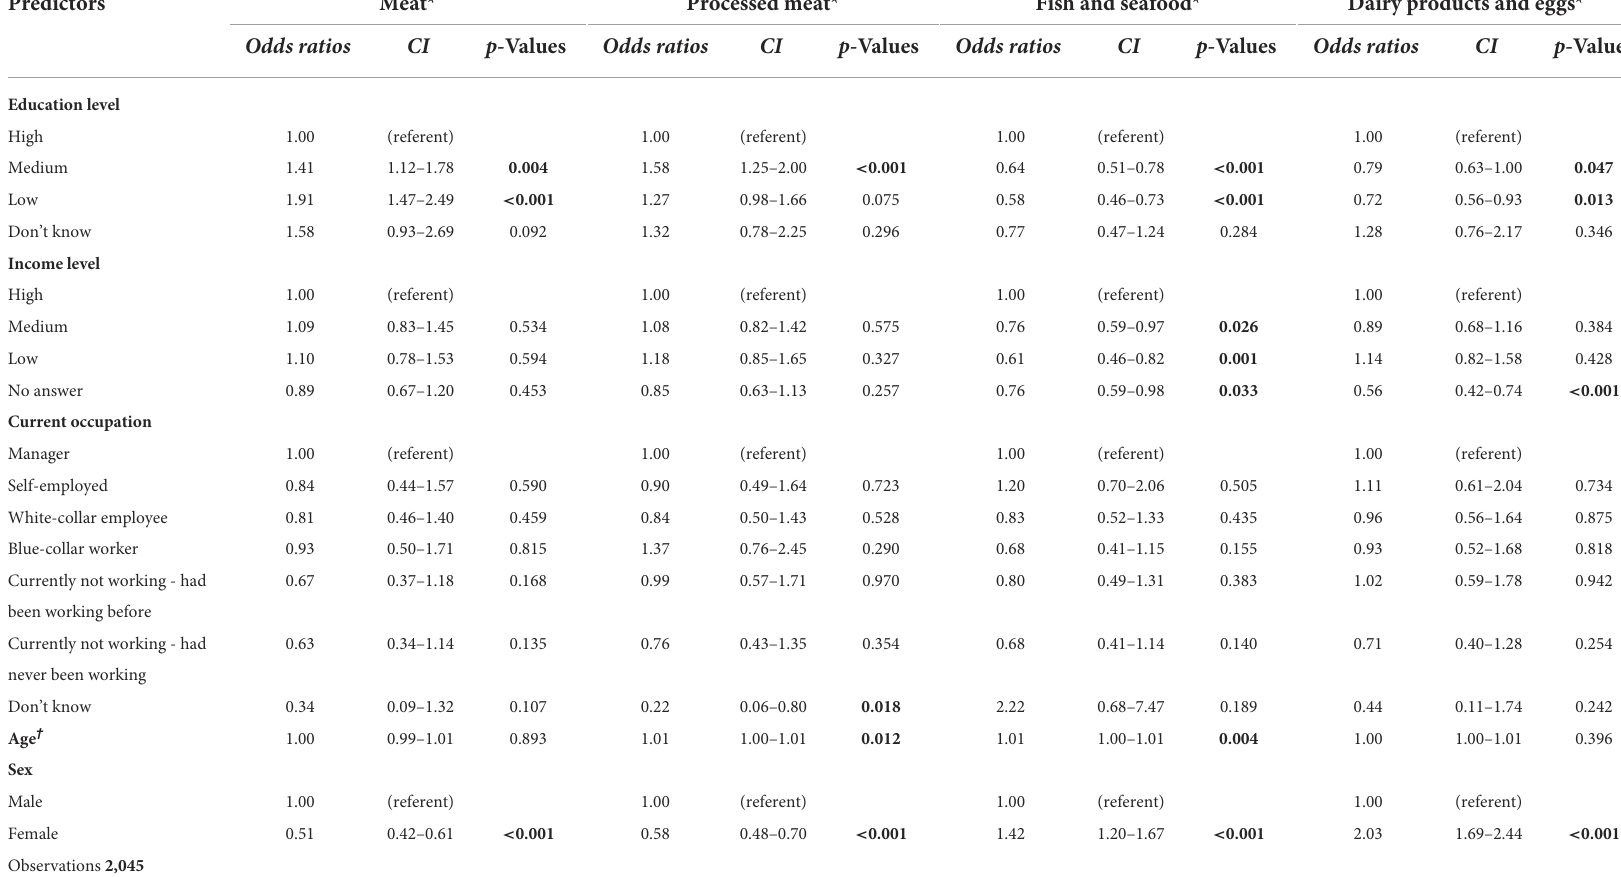
TABLE 4 Odds ratios, 95% confidence intervals and p -values for frequency of consumption of animal products 2017/18.